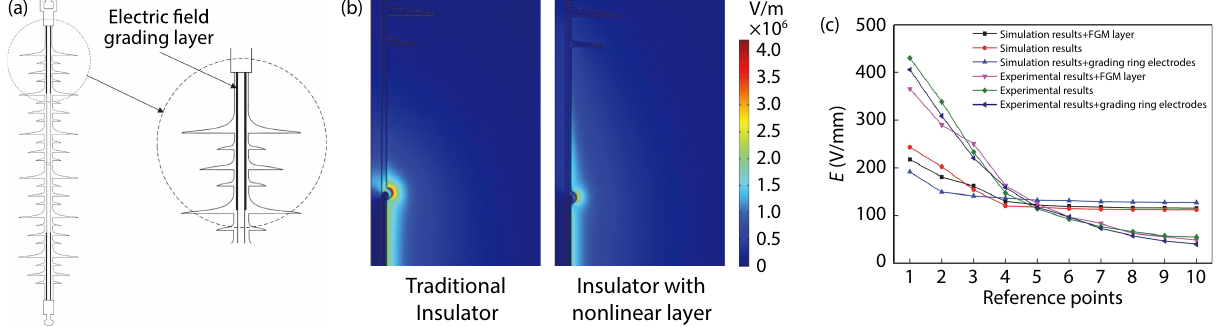
Fig. 5 Application of SADs in polymeric outdoor insulators. ( a ) Schematic of insulators with nonlinear materials. ( b ) Electric field distribution of traditional and novel insulators. ( c ) Electric field distributions from simulations and experiments at 10 reference points along the 220 kV insulator. Reproduced with permission from ref. [50], © 2018 IEEE.